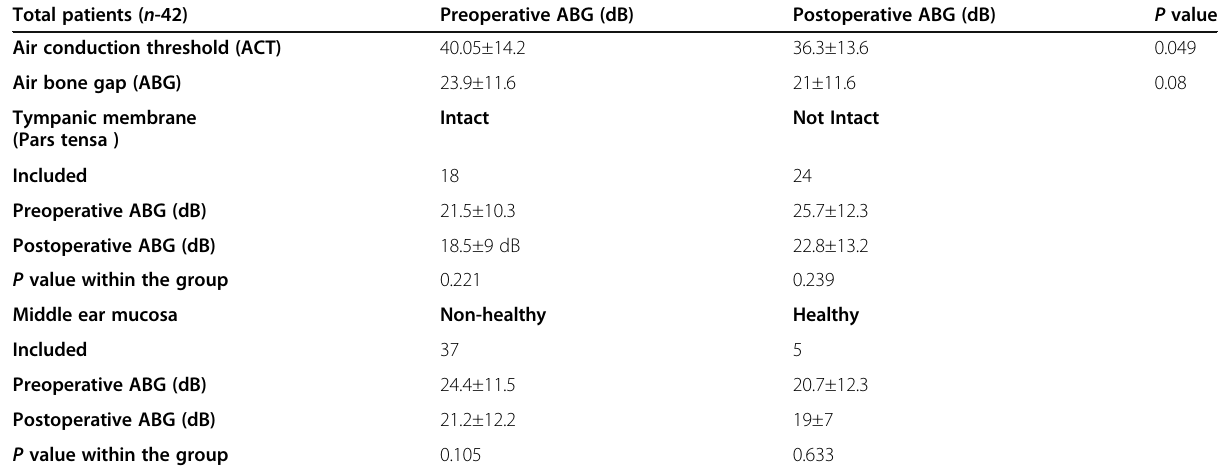
Table 2 Hearing results Total patients ( n -42)